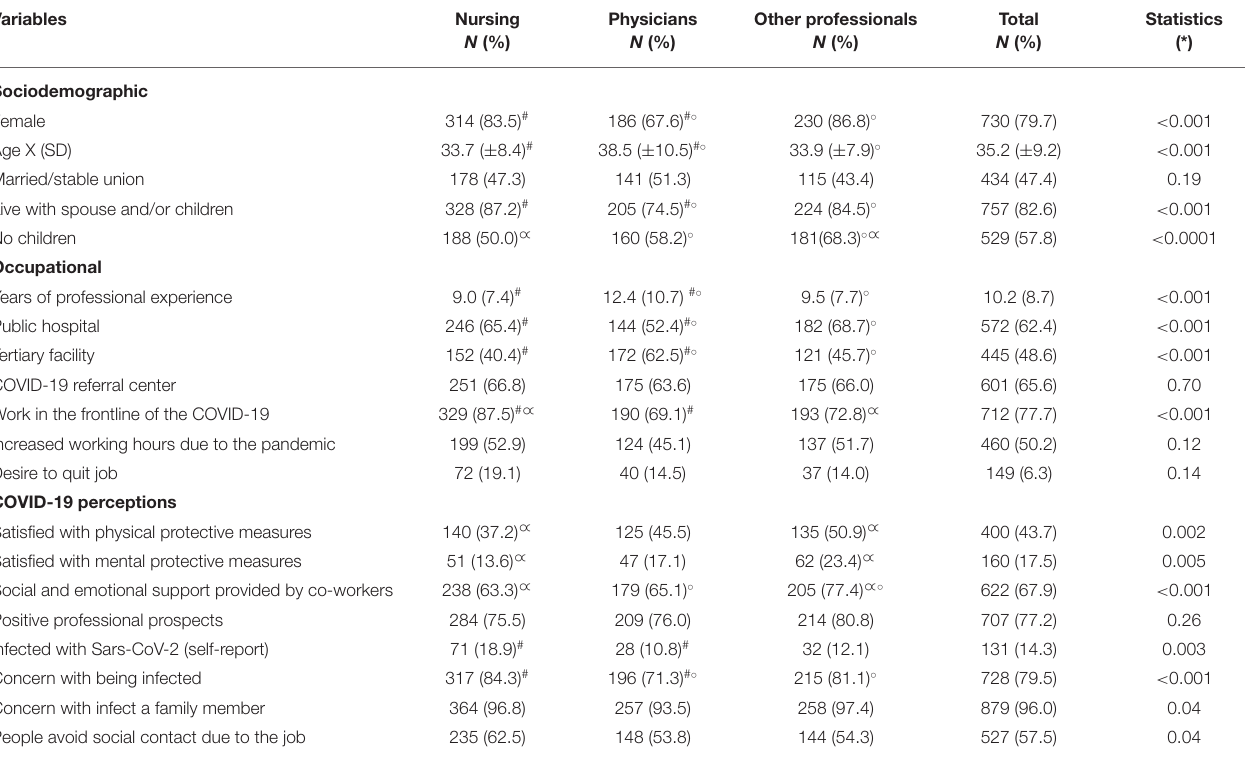
TABLE 1 | Sociodemographic and occupational characterization and risk perception of contamination by the Sars-CoV-2, considering three groups of workers ( n = 916). Variables